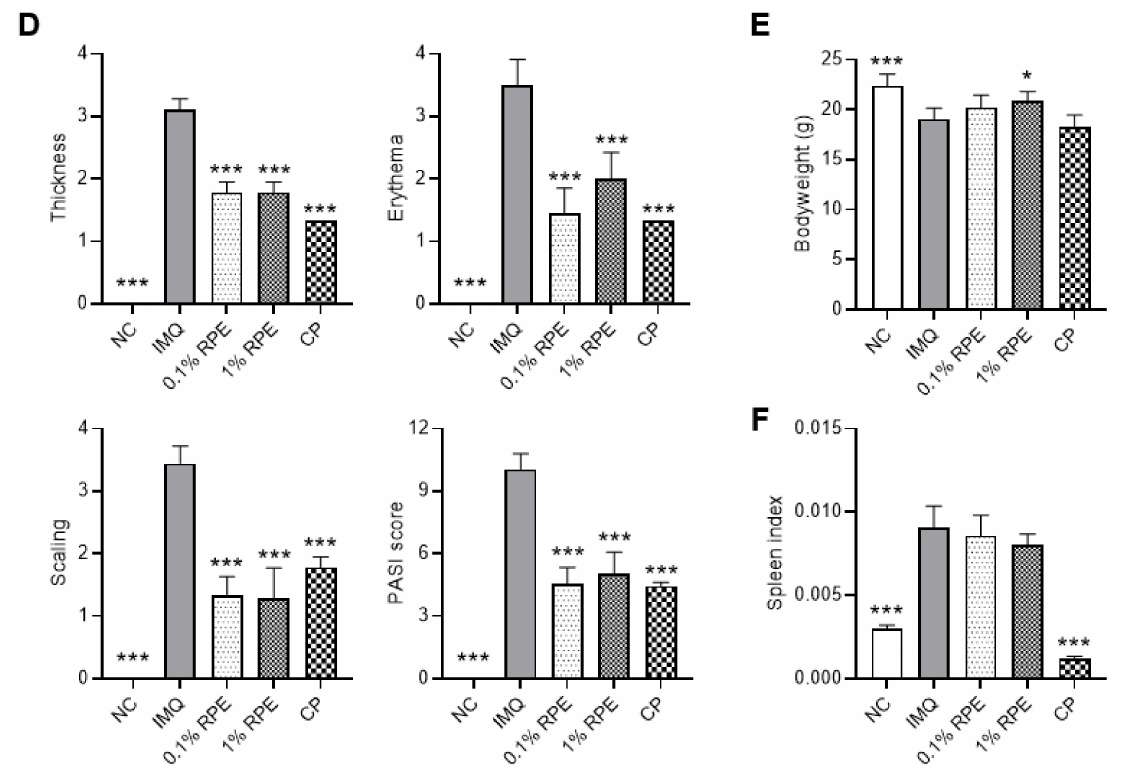
Figure 1. Effects of RPE on psoriasis-like symptoms in IMQ-induced mice. ( A ) Experimental schedule for IMQ-induced psoriasis model and treatments. ( B ) Representative images of skin lesions. ( C ) Skin analysis by CosCam. Blue: very low score, green: low score, yellow: normal score, light orange: high score, dark orange: very high score. ( D ) PASI score of skin lesions, including thickness, erythema, and scaling (0–4) and a total score (0–12). ( E ) Body weight of mice from five groups. ( F ) Spleen index was defined as the ratio of spleen weight and body weight. Data are expressed as means ± SDs ( n =